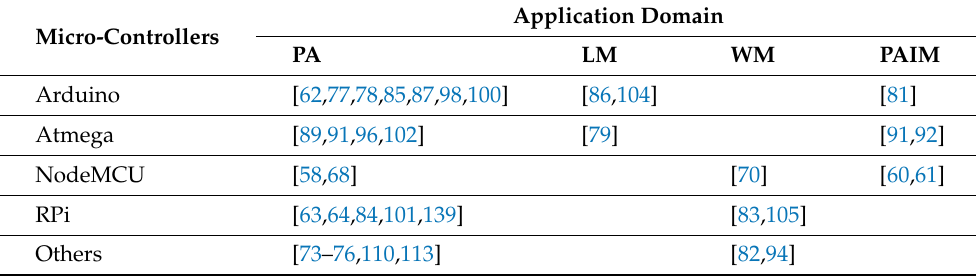
Table 4. Major micro-controllers used in smallholder agriculture application projects (PA:Precision Agriculture, LM: Livestock Management, WM: Weather Monitoring, PAIM: Pest and Animal Infesta- tion